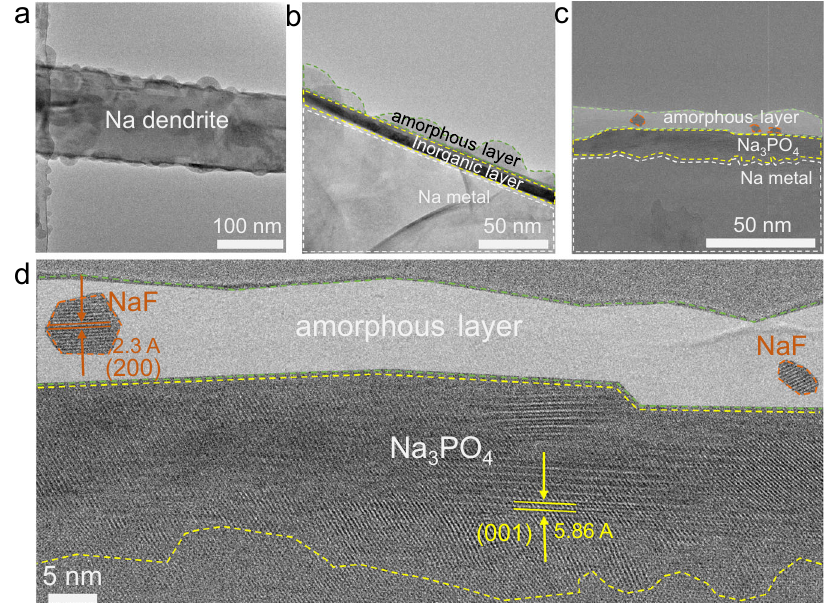
Fig. 3 Cryo-TEM analysis of the SEI formed in EC:DMC-FEC electrolyte after the 1st cycle. a Low-magni fi cation cryo-TEM image of the Na dendrite. b Magni fi ed view of the surface region. c , d cryo-HRTEM of the SEI showing the distribution of Na metal, NaF outlined in orange, Na 3 PO 4 outlined in yellow, and amorphous layer highlighted in white.